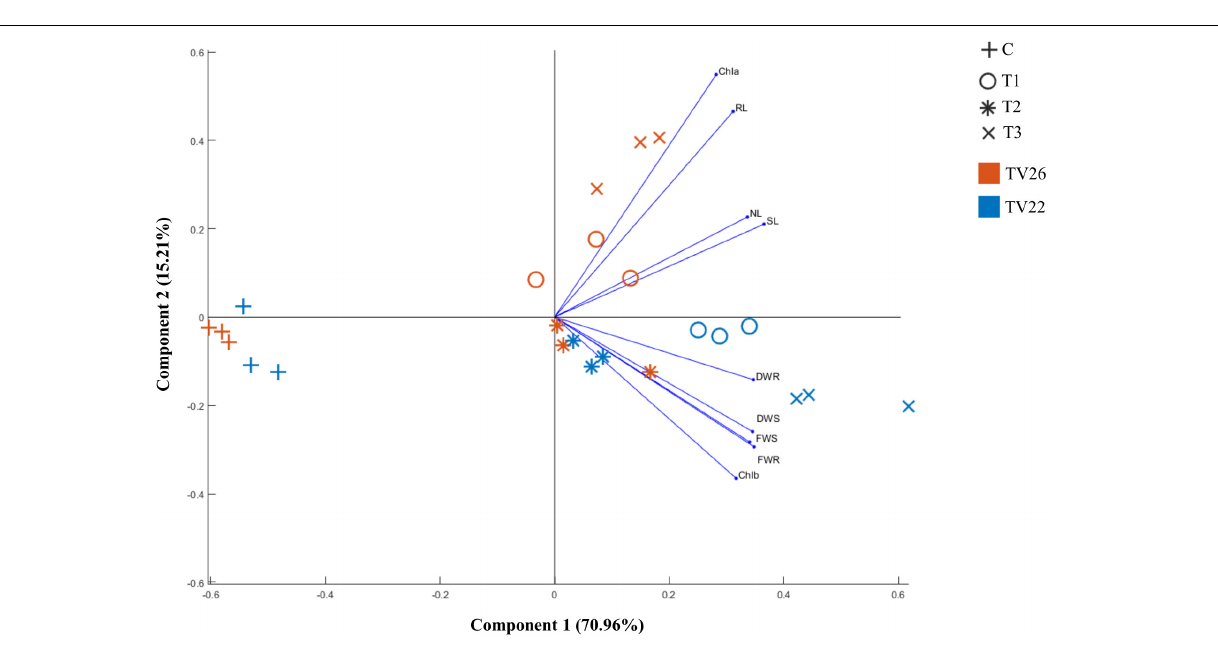
FIGURE 8 | Principle component analysis biplot based on correlation matrices of the PGP dataset of growth parameters and treatment groups of tea clones TV22 and TV26. C- Control, Untreated plant; T1-Treatment 1, K96 ( Stenotrophomonas sp.); T2- Treatment 2, M45 ( Pseudomonas sp.); T3- Treatment 3, Consortia of K96 and